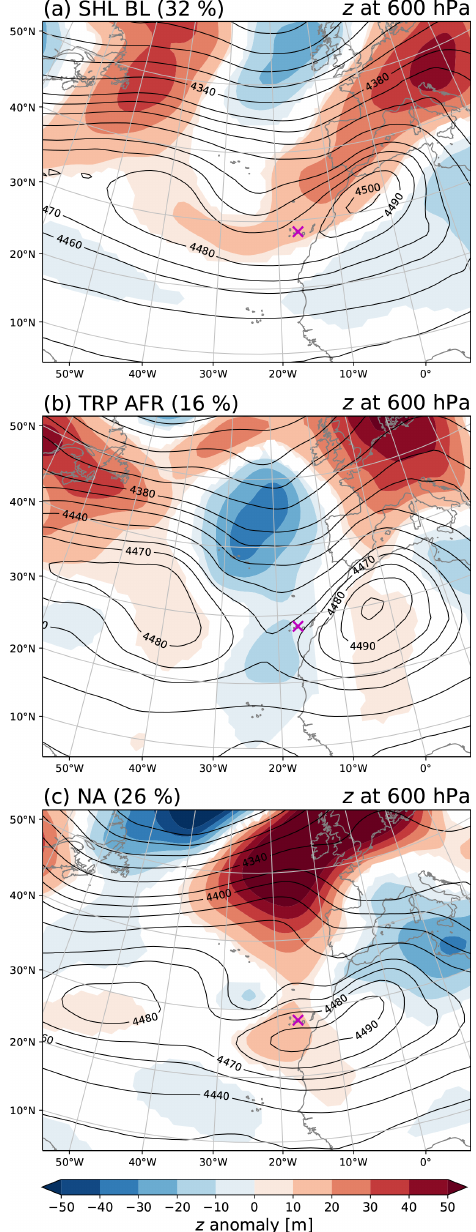
Figure 13. Anomalies of geopotential height z at 600hPa from the climatological mean of July and August in the period 1979–2018 for three different transport regimes: (a) air parcels originating from the boundary layer of the Saharan heat low (SHL BL), (b) air parcels coming from tropical Africa (TRP AFR), and (c) air parcels origi- nating from the North Atlantic (NA). The classification of the trans- port pathways relies on the origin of air parcels arriving at 600hPa above Tenerife. The composites depict the synoptic-scale conditions 3d prior to the arrival of the respective air parcels. Coloured shad- ings show significant anomalies ( p < 5%) from the climatological mean. Contour lines represent the mean state of the respective trans- port regime in July and August 2013. The percentages in brackets in the title indicate the occurrence frequency of the transport pathways in July and August